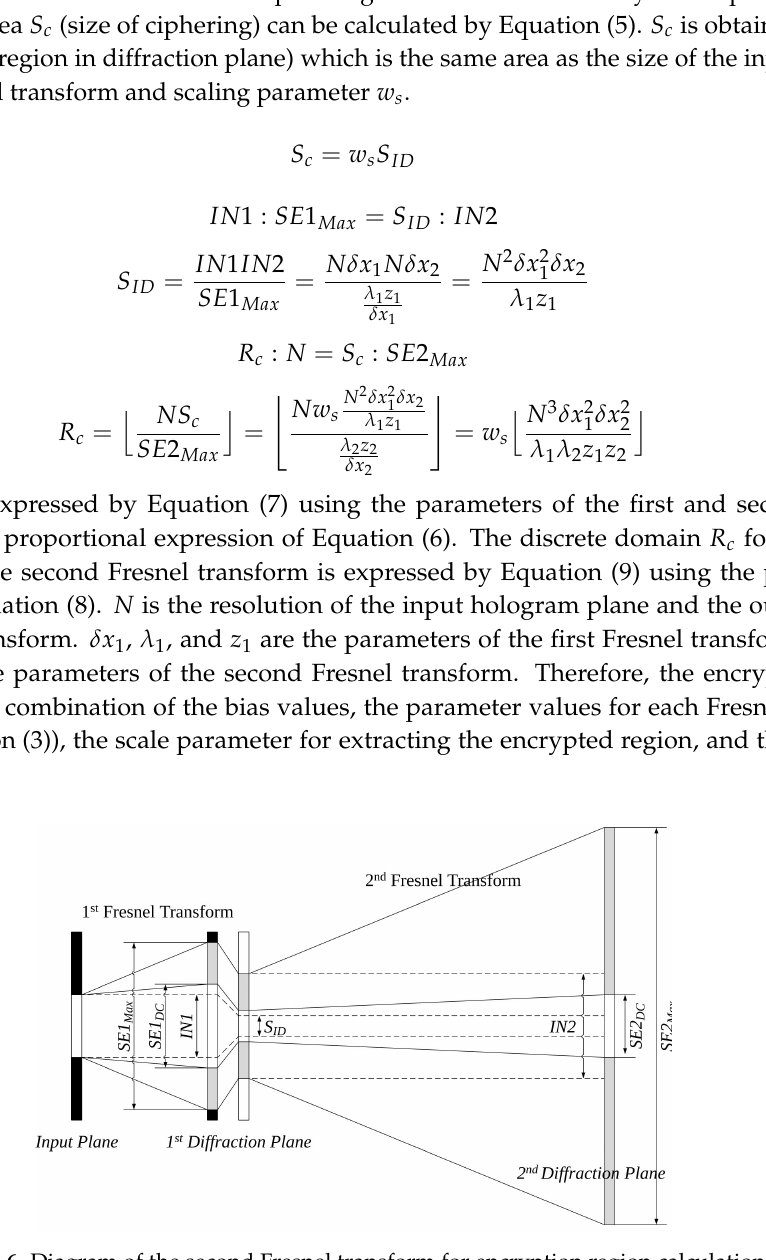
Figure 6. Diagram of the second Fresnel transform for encryption region